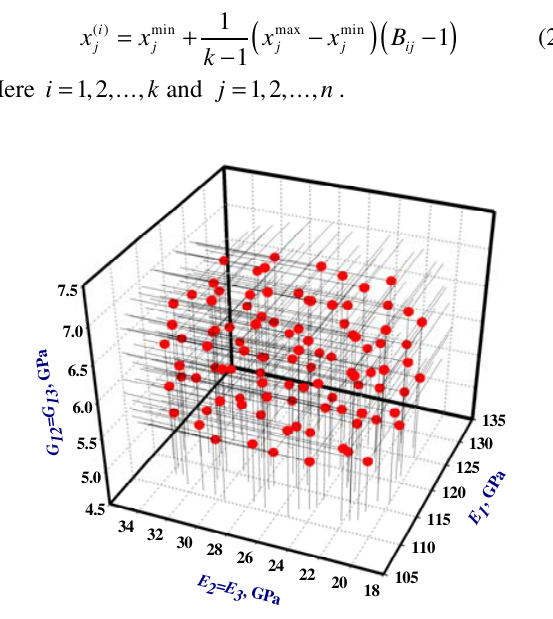
Fig 4. Plan of experiment: